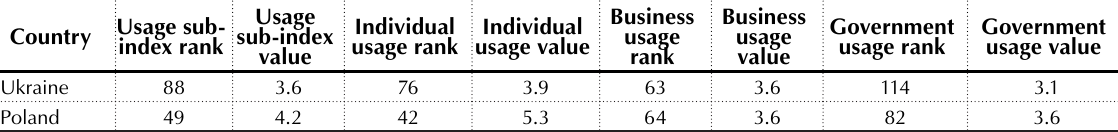
Table 8. Usage sub-index and pillars for Ukraine and Poland